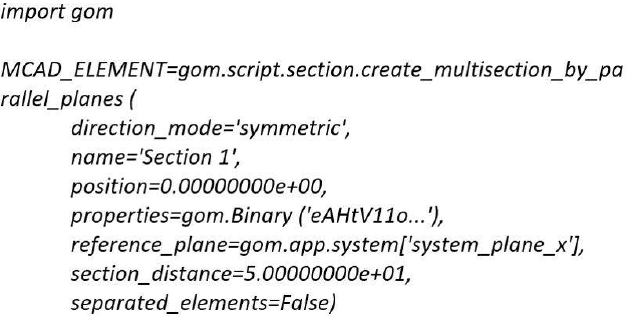
Figure 9. One of the recording results.